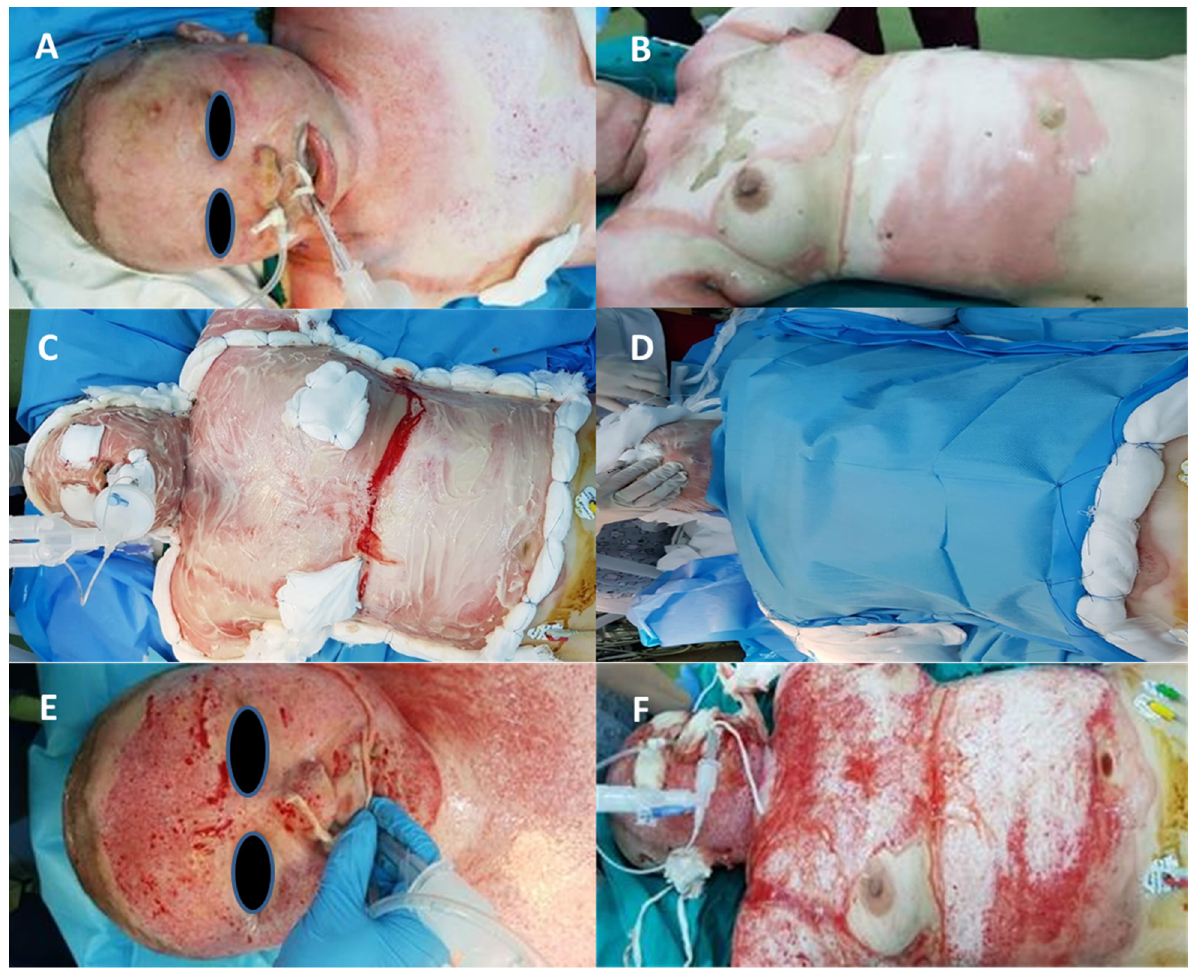
Figure 3. Bromelain application. ( A , B )—deep burn before bromelain application, ( C )—bromelain application, ( D )—oclusive dressing, ( E , F )—after bromelain application.